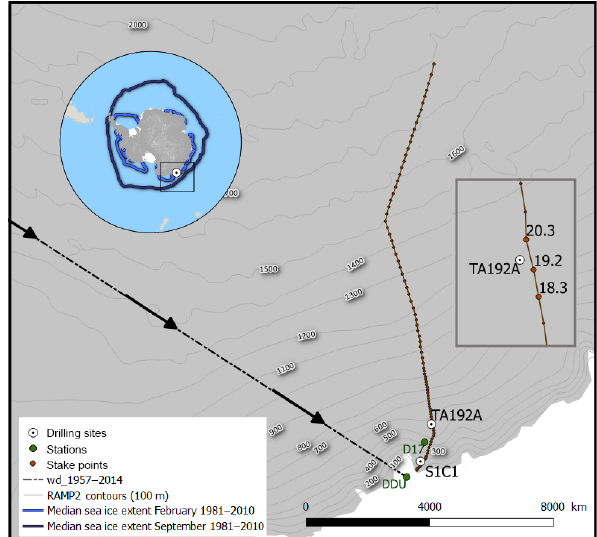
Figure 1. Map showing the location of the drilling sites of the S1C1 and TA192A firn cores (black points), the Dumont d’Urville and D17 stations (green points), the stake points (in brown; in- cluded the three closest stake points from the TA192A, namely the 18.3, 19.2, and 20.3 lines, and 156km stake line), and the mean wind direction over the period 1957–2014 (in black). Isohypses (grey lines) shown in the main figure are simulations from adigi- tal elevation model, large-scale resolution. Radarsat Antarctic Map- ping Project Digital Elevation Model version 2 (Liu et al., 2001). The map of Antarctica on the top left displays the mean February and September sea ice extent over the period 1981–2010 extracted from the Nimbus-7 Scanning Multichannel Microwave Radiome- ter (SMMR) and Defense Meteorological Satellite Program Spe- cial Sensor Microwave/Imagers – Special Sensor Microwave Im- age/Sounder (DMSP SSM/I-SSMIS) passive microwave data (http: //nsidc.org/data/nsidc-0051, last access: January 2018) (Cavalieri et al., 1996) (light blue and dark blue lines respectively), and the zoomed area (grey rectangle), while the grey rectangle in the mid- dle right zooms the area around the TA192A drilling site in order to show the three closest stake